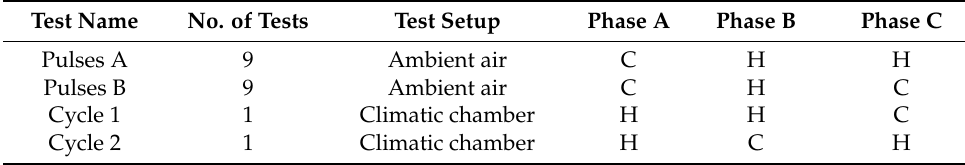
Table 1. Summary of the conducted thermal tests.